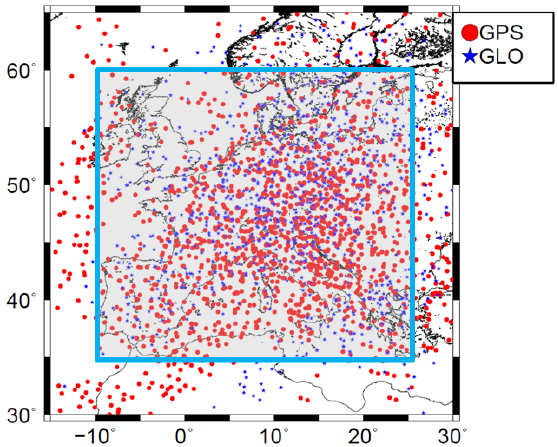
Figure 7. Distribution of the IPPs of the GPS and GLONASS observations from 17 March 2015 at 12:00 UT; the IPPs within the blue box are selected for the regional data set D 2 .